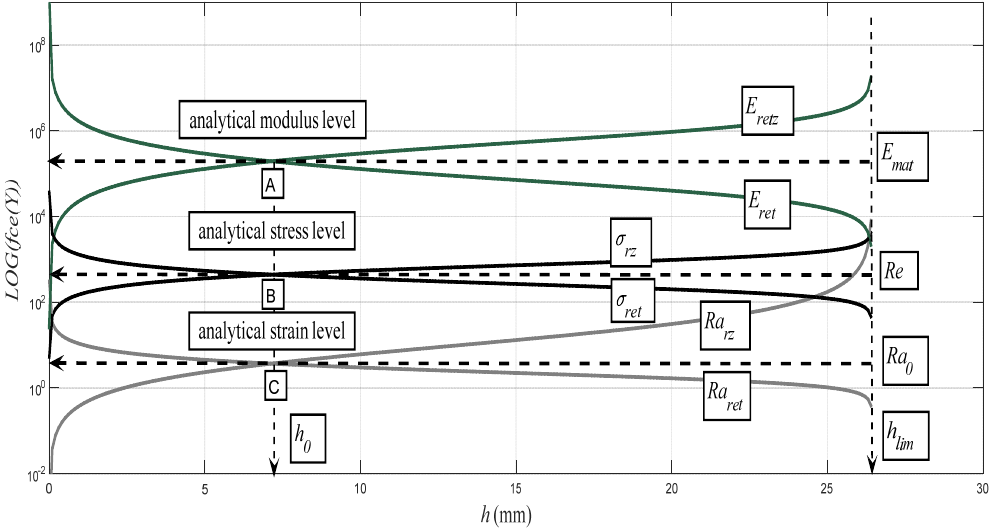
Figure 7. Steel S355J0, E mat = 194.5 GPa, analytical derivation of the position of the yield point Re , including the position of the neutral plane h 0 , the value Re being read from the σ rz curve at the level h 0 , i.e., Re = σ rz 0 ; the yield point Re is defined by the intersection of the curves for the pressure and tensile stress components σ rz and σ ret . At this intersection at the neutral depth, h 0 applies Re = σ rz 0 = σ ret 0 . (Components E retz , E ret of analytical modulus level are marked green color, components of analytical stress level σ rz , σ ret are marked black color, components of analytical strain level Ra rz , Ra ret are marked gray color)